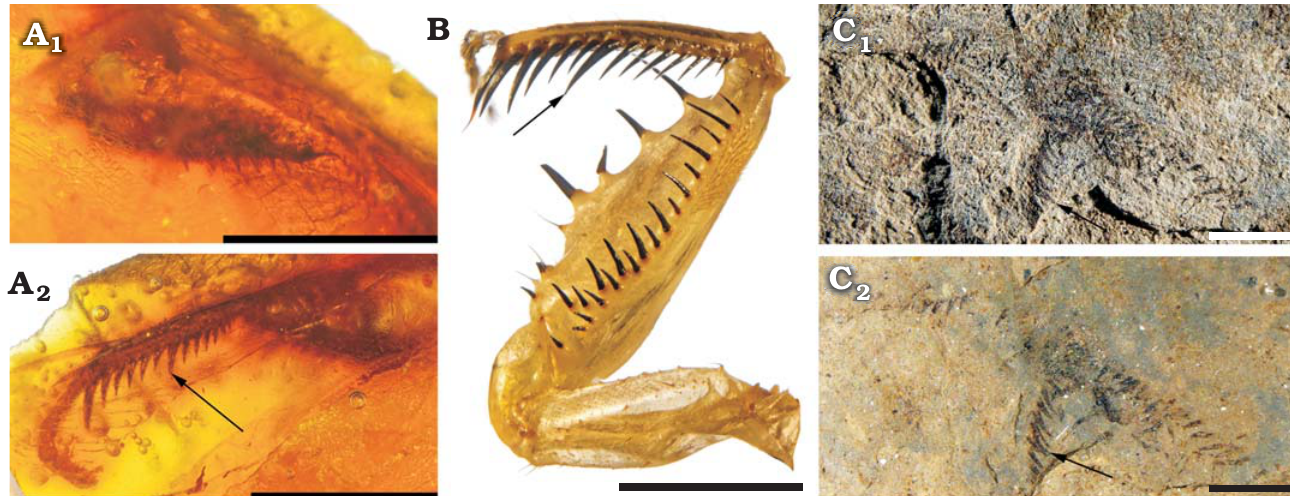
Fig. 4. Fore legs of chaeteessid mantodeans. A . Chaeteessidae gen. at sp. incertae sedis, MNHN-F.A71139, Le Quesnoy, France, Eocene; inner (A 1 ) and outer (A 2 ) side of left fore femur. B . Fore legs of Chaeteessa valida (Perty, 1833), Recent, MNHN collection. C . Habitus of Arvernineura insignis Piton, 1940, MNT NEL1656, Menat, France, Paleocene; photograph with low-angle light (C 1 ), in alcohol (C 2 ). Arrows correspond to tibial major median spines. Scale bars 2 mm.